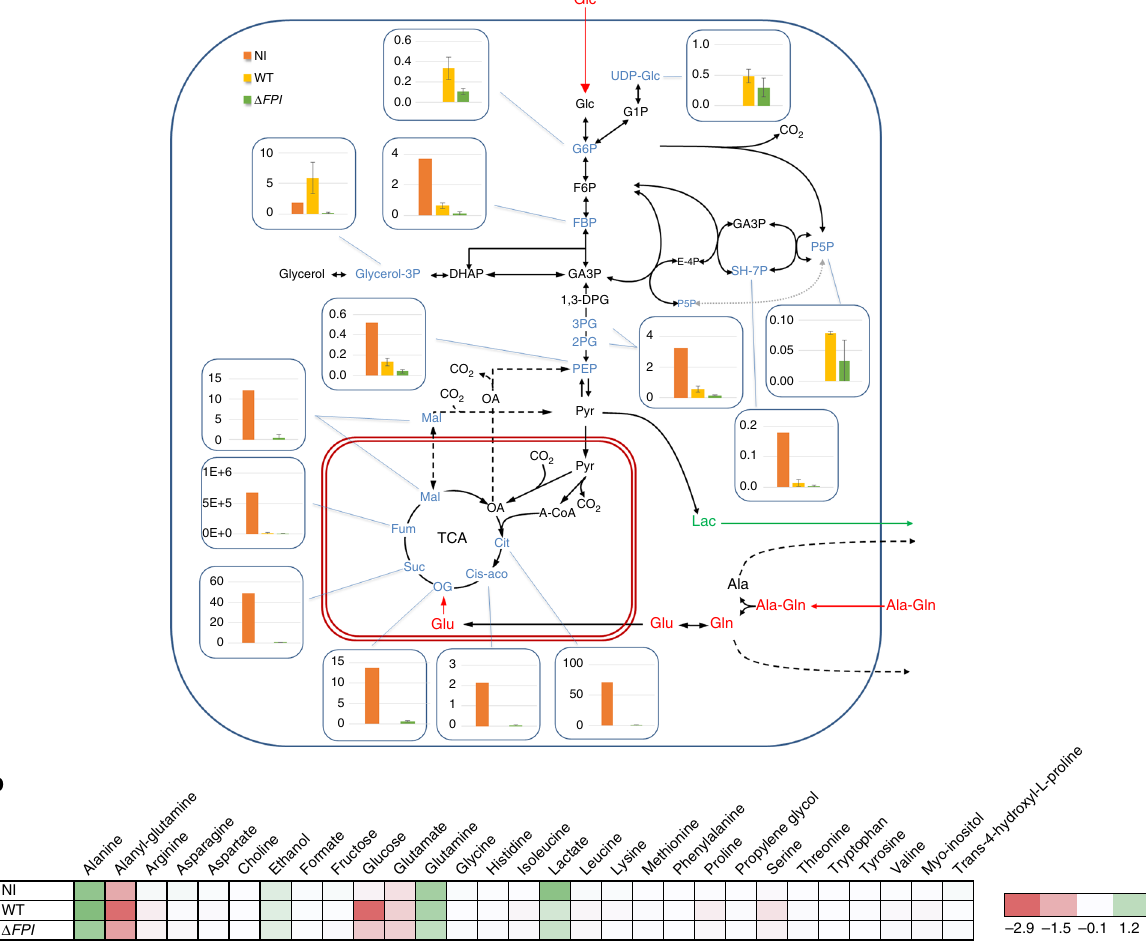
Fig. 1 Carbon isotopologue distribution of central metabolites in BMMs. a Absolute concentrations of central metabolites in intracellular cell extracts (in µ mol L − 1 ) after 24 h of cultivation of BMM macrophages: NI ( n = 1); or infected either with wild-type F. novicida (WT) ( n = 3) or Δ FPI ( Δ FPI) strain ( n = 3). Fumarate measurements (Fum) represent MS peak area instead of absolute concentrations. b Consumed and produced metabolites, measured in extracellular media in the different infection conditions, pro fi led by NMR. Mean concentration changes, presented here by substracting concentration measured at 24 h to those measured at 1 h. Absolute concentrations changes are expressed in mM. Positive/green values correspond to metabolites accumulated in the media, negative/red values correspond to metabolites consumed by cells from the media between 1 and 24 h of incubation. Analyses were performed on biological triplicates and each sample was run in technical triplicates (mean and SD of metabolite concentrations were calculated using R 3.2.3, R Foundation for Statistical Computing, Vienna, Austria. URL